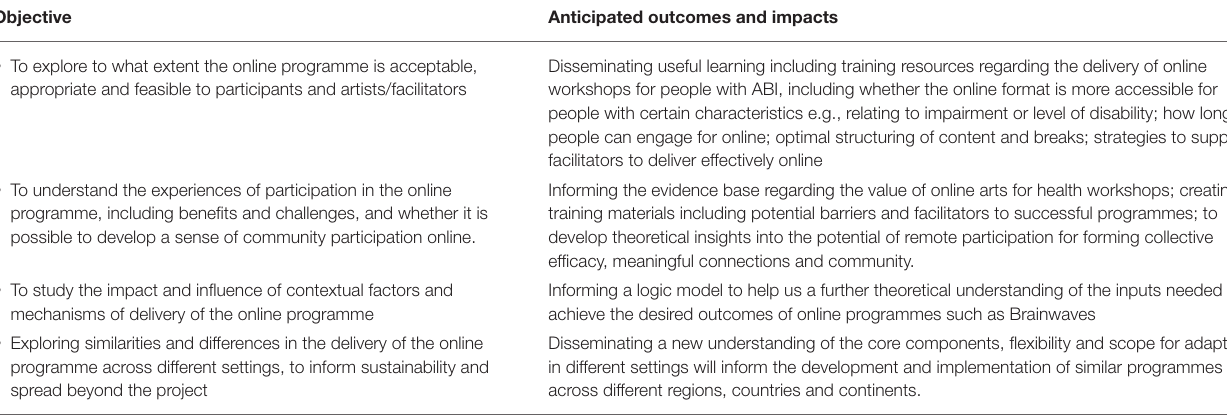
TABLE 1 | Objectives and anticipated outcomes and impacts. Objective Anticipated outcomes and